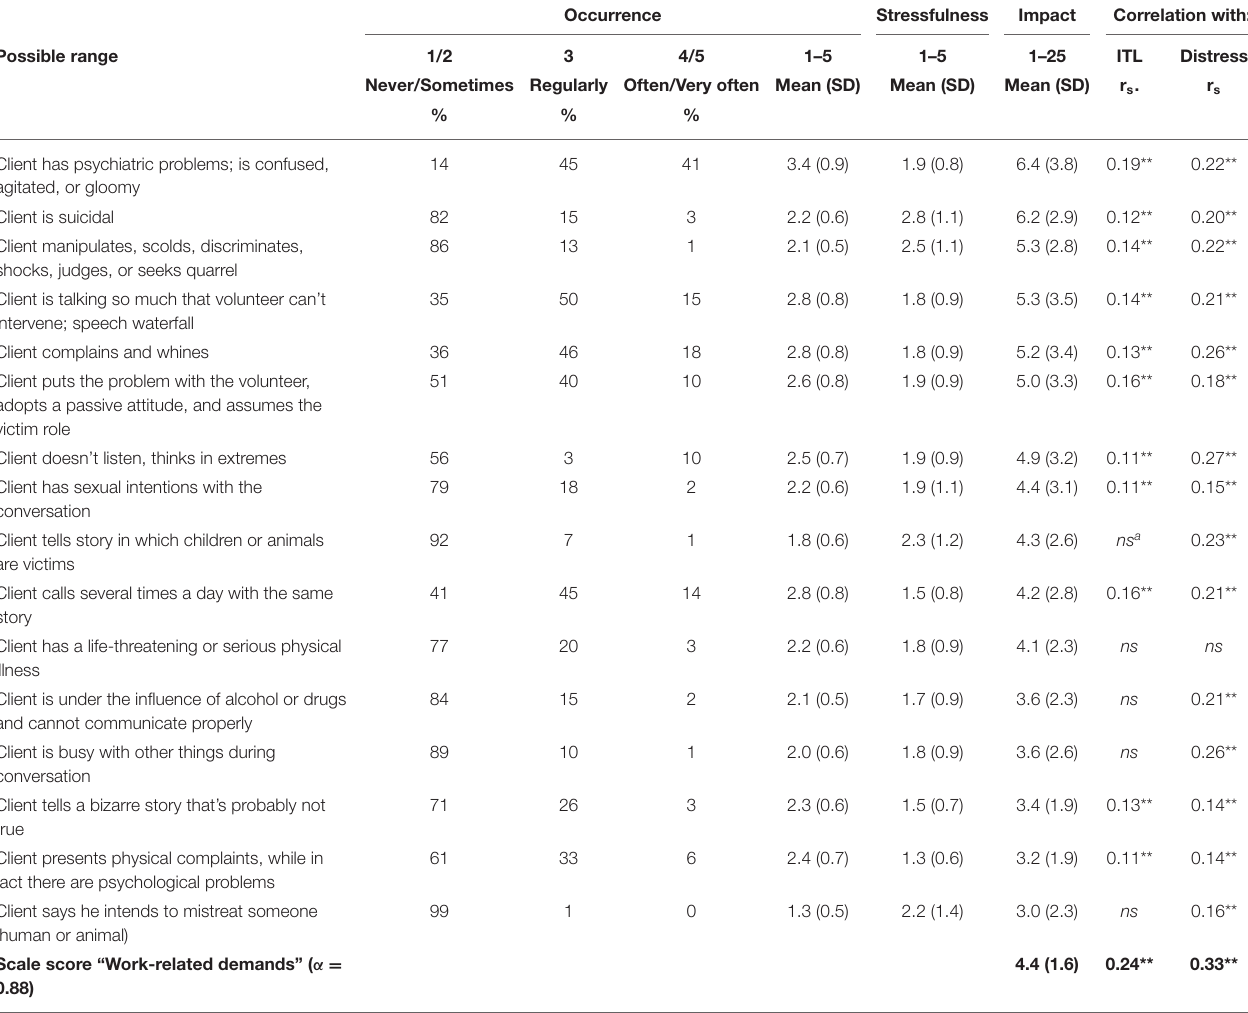
TABLE 2 | Summary of descriptive statistics work-related demands: frequency, degree of stress, and impact (product frequency and degree of stress)* and Spearman’s rho correlations with Intention to Leave (ITL) and Distress ( N = 543). Occurrence Stressfulness Impact Correlation